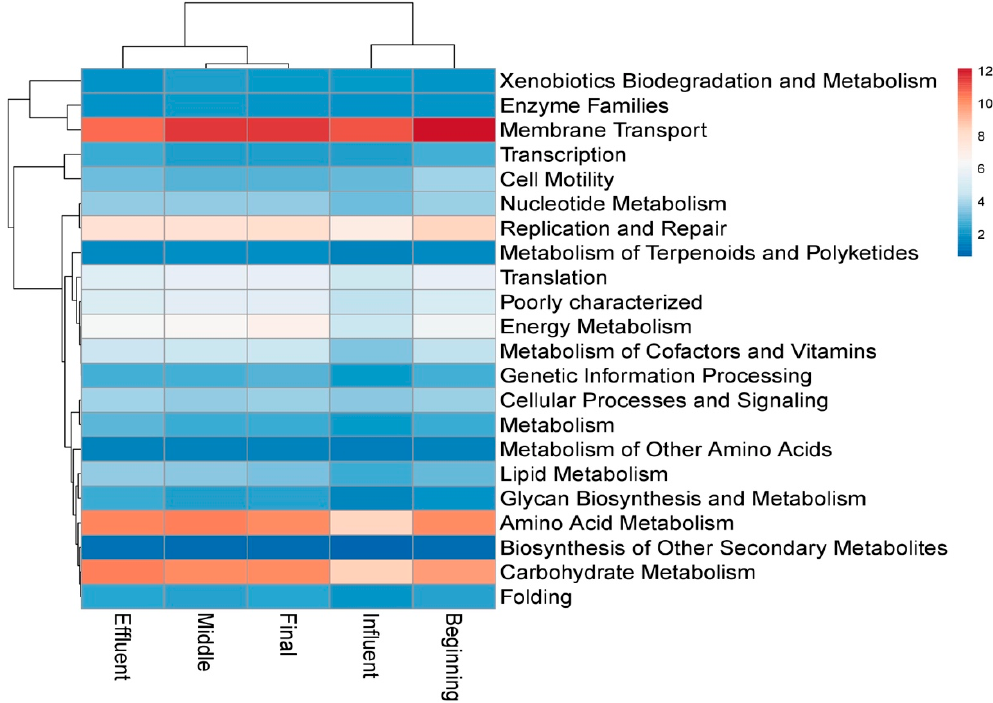
Figure 5. Heatmap of the functional prediction by PICRUSt at five sampling sites.